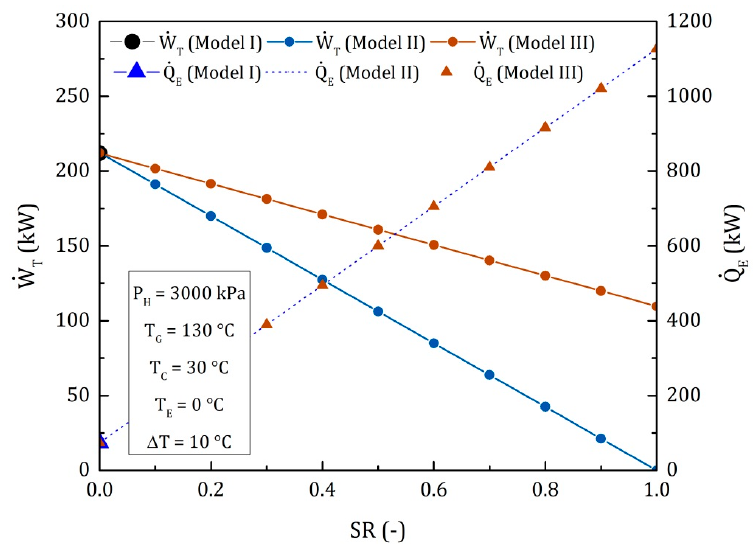
. . Figure 15. Comparison of W(cid:4662) (cid:2904) and Q(cid:4662) (cid:2889) as a function of SR for the three models. Figure 15. Comparison of W T and Q E as a function of SR for the three models. Figure 15. Comparison of W(cid:4662) (cid:2904) and Q(cid:4662) (cid:2889) as a function of SR for the three models.